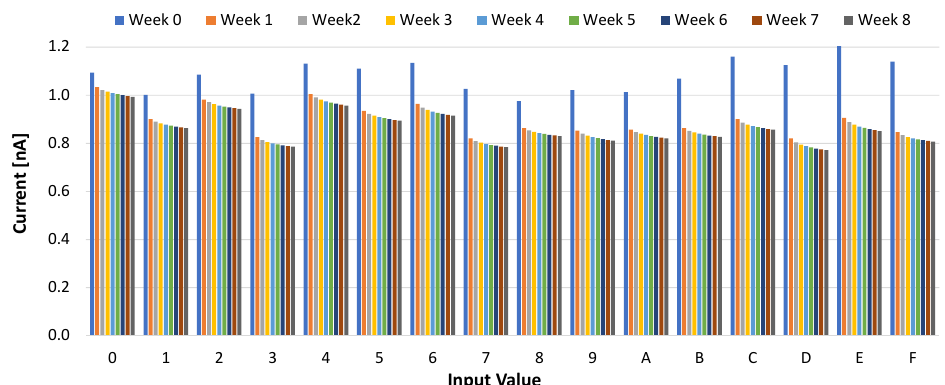
Figure 6: Simulated static current change for different aging duration and input stimuli.